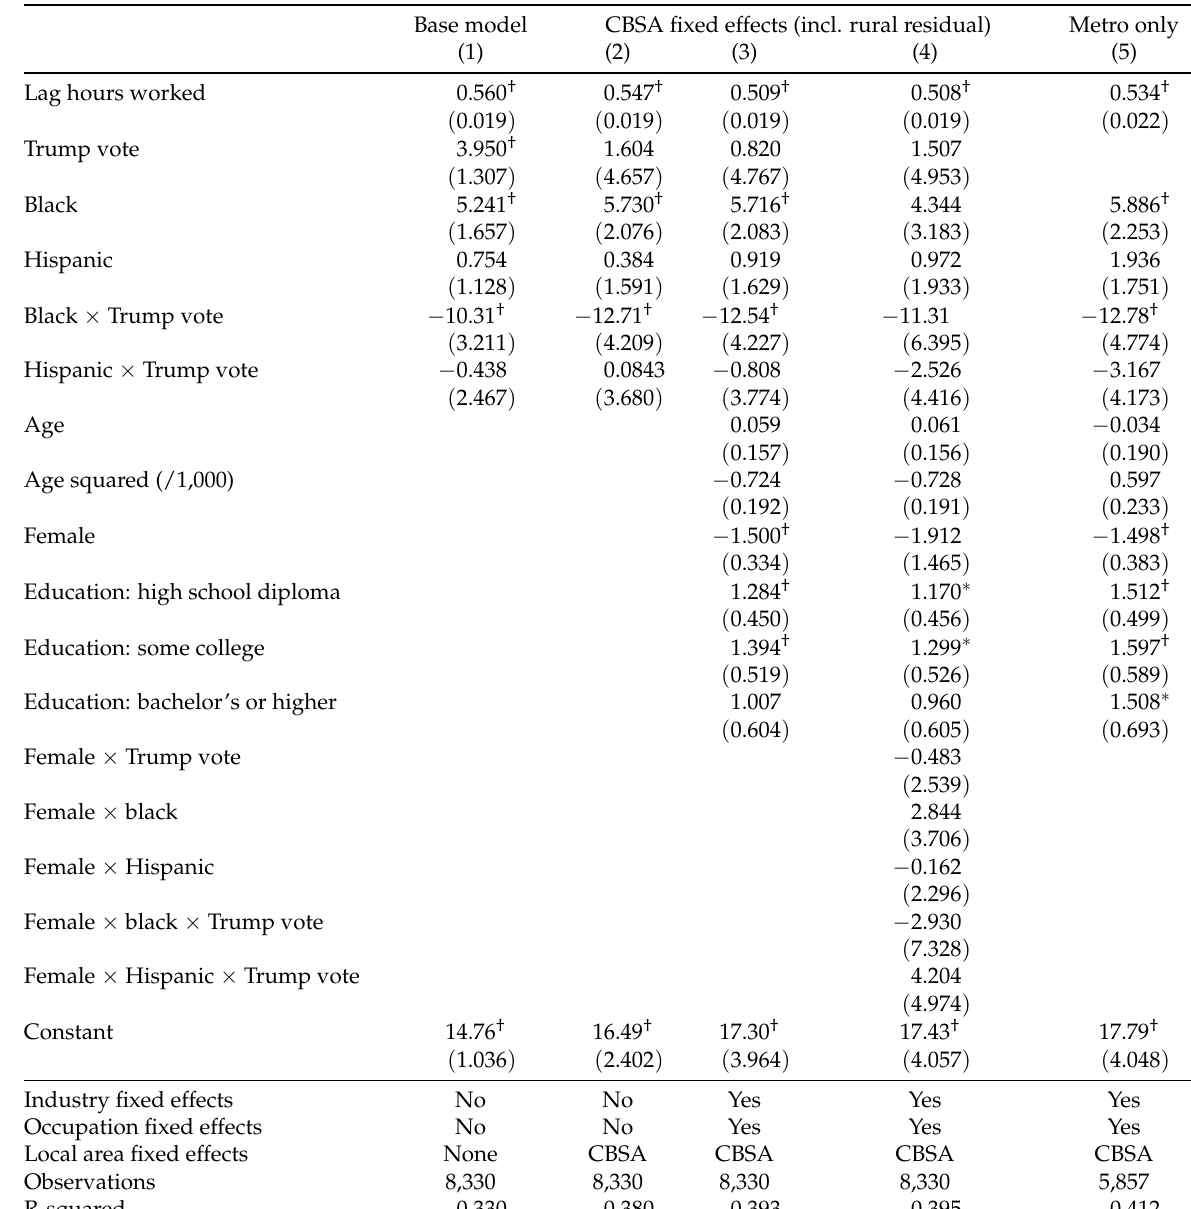
Table 2: Estimates from two-period lagged dependent variable models of weekly hours worked among hourly paid workers, pre- and post-2016 election Base